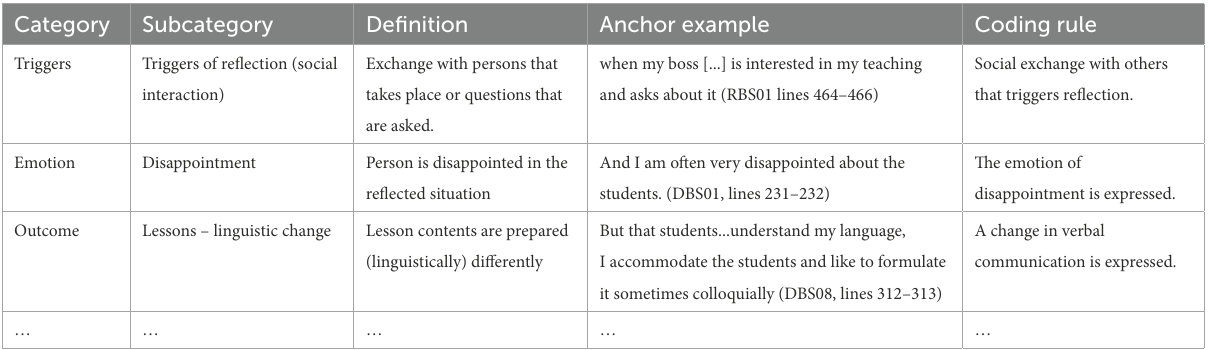
TABLE 1 Extract from coding